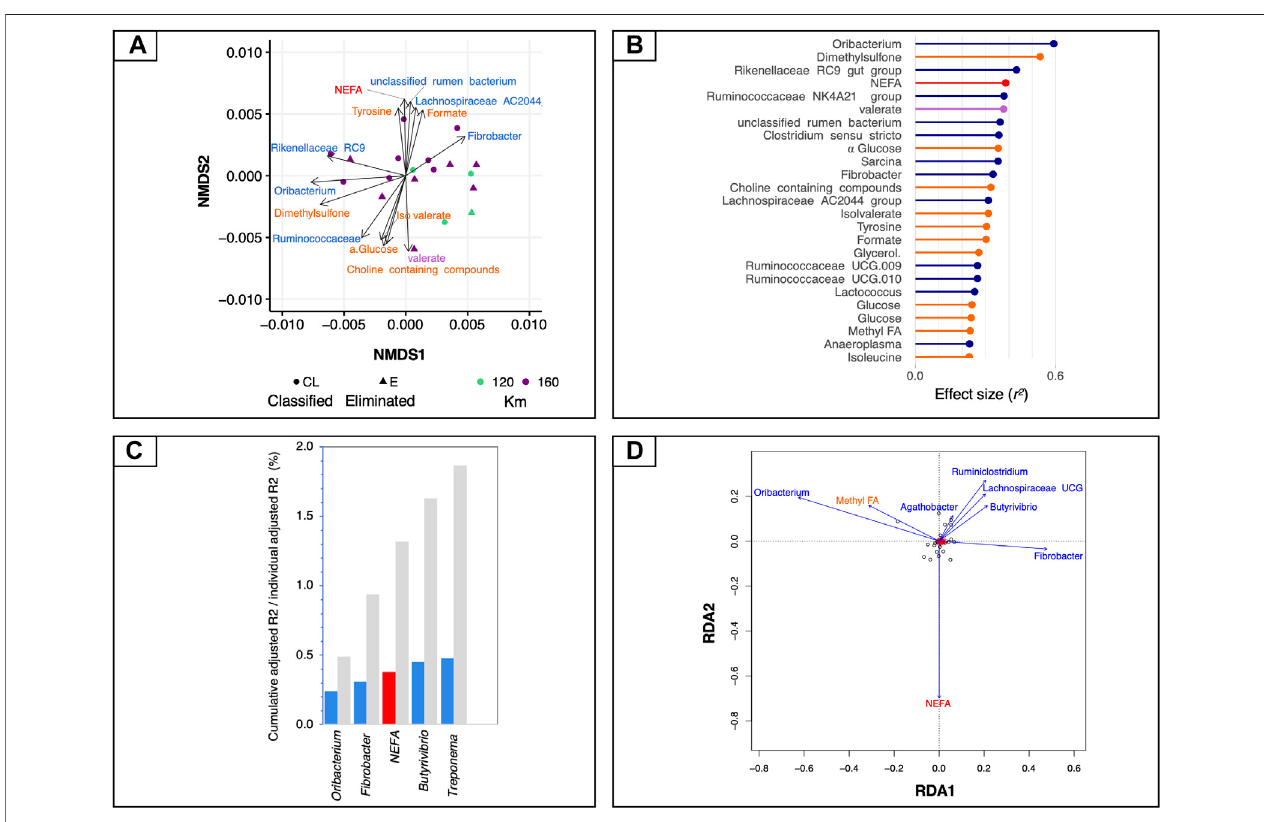
FIGURE 3 | Associations between mt-related genes, microbiota and circulating metabolites. (A) Dissimilarities in mt-related gene expression represented by the non-metric multidimensional scaling (NMDS) ordination plot. The Bray – Curtis dissimilarity index was calculated on normalised data; the samples were coloured according to the total length of the race and the two different shapes of the dots indicate if the horses fi nished the race or if they were eliminated. (B) Effect sizes of gut microbiota, fecal SCFAs, 1 H NMR and biochemical assay metabolites over NMDS ordination. Covariates are coloured according to the type of dataset: 1 H NMR metabolites are in orange, biochemical assay metabolites in red, fecal SCFAs in violet and bacteria in dark blue. Horizontal bars show the amount of variance ( r 2 ) explained by each covariate in the model as determined by ‘ env fi t ’ function. (C) Grouped bar chart showing the cumulative effect sizes of covariates on mt-related gene expression (coloured bars) compared to individual effect sizes assuming covariate independence (grey bars) using a stepwise model selection using distance-based redundancy analysis (dbRDA). Covariates are coloured according to the type of dataset: red for biochemical assay metabolites, and blue for bacteria. (D) Plot showing the covariates that contribute signi fi cantly to the variation of mt-related genes determined by stepwise model selection using redundancy analysis (RDA). The arrows for each variable show thedirection oftheeffect and arescaled bythe unconditioned r 2 value. Covariates arecoloured according tothe type ofdataset: red for biochemical assay metabolites and dark blue for